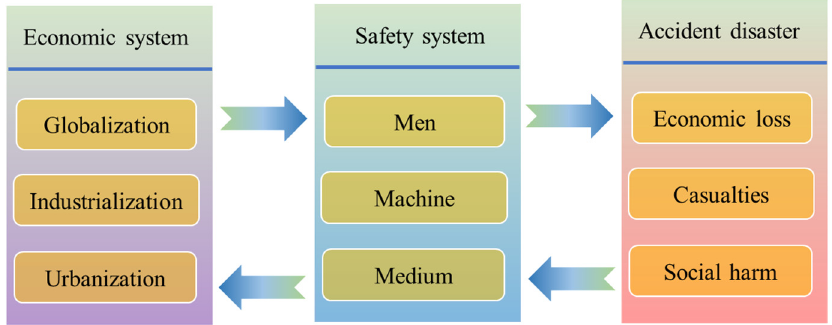
Figure 3. The correlation between safety incidents and economic